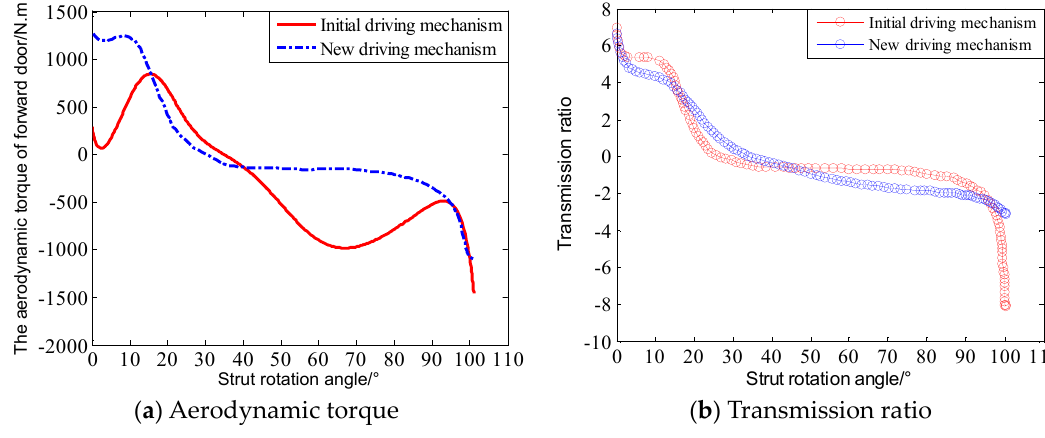
Figure 10. Test results of initial and new driving mechanisms at 270 Kts.